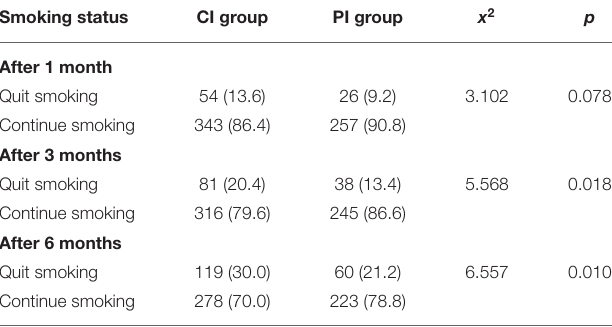
TABLE 3 | Short-term effects in the intervention groups after receiving smoking cessation intervention.